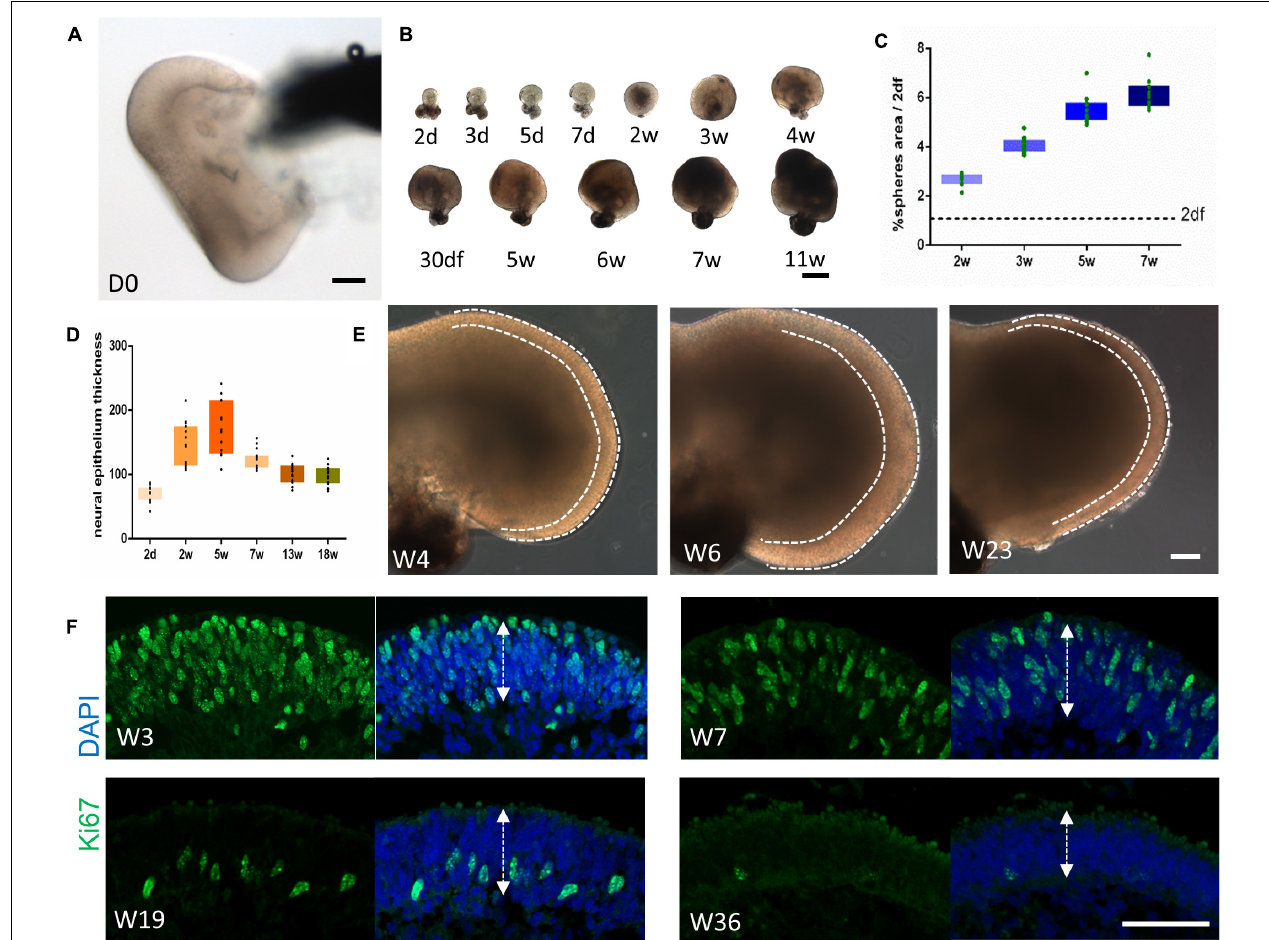
FIGURE 2 | Morphogenesis of retinal organoids. (A) Bright-field imaging showing the cup-like structure of the retinal organoid immediately after isolation. Scale bar = 100 µ m. (B) Variation in the growth rate of retinal organoids at different time points. Scale bar = 500 µ m. (C,D) The growth rate was quantified by sphere size [ (C) , n = 10 retinal organoids from three independent experiments] and neural retina thickness [ (D) , n = 15 retinal organoids from three independent experiments]. (E) Representative images at Week 4, Week 6, and Week 23 showing the changes in the thickness of the neural retina (dashed line). Scale bar = 100 µ m. (F)